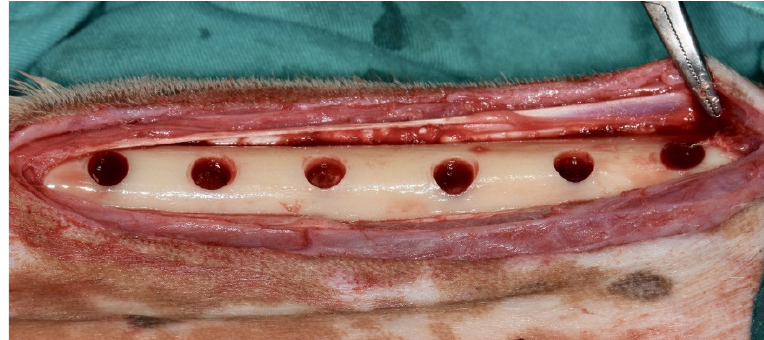
Figure 2. 6 defects on each sheep’s tibia were prepared with trephine bur.